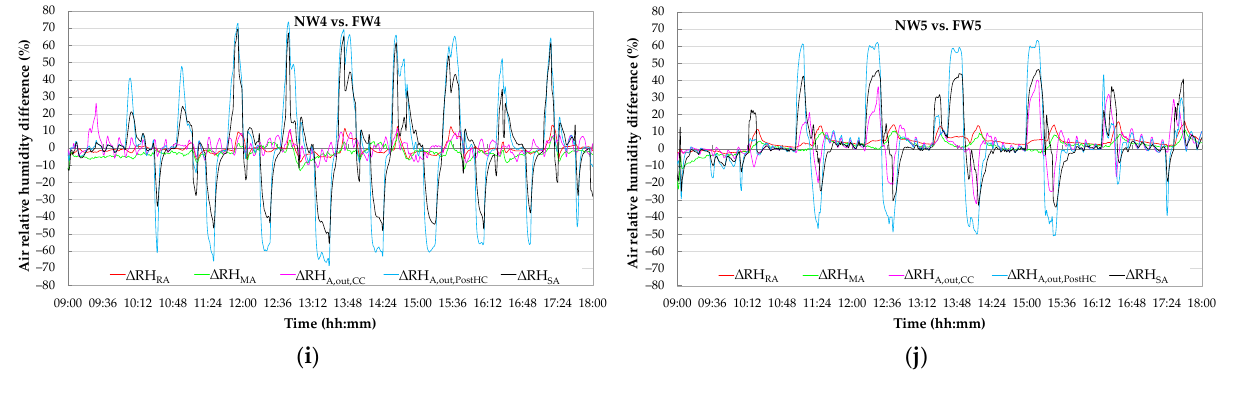
Figure A4. Comparison of faulty and fault-free tests in terms of ∆ RH RA , ∆ RH MA , ∆ RH A,out,CC , ∆ RH A,out,PostHC and ∆ RH SA (Equations (A6)–(A10)): comparison between NS1 and FS1 ( a ), NS2 and FS2 ( b ), NS2 and FS3 ( c ), NS1 and FS4 ( d ), NS3 and FS5 ( e ), NW1 and FW1 ( f ), NW2 and FW2 ( g ), NW3 and FW3 ( h ), NW4 and FW4 ( i ), NW5 and FW5 ( j ).